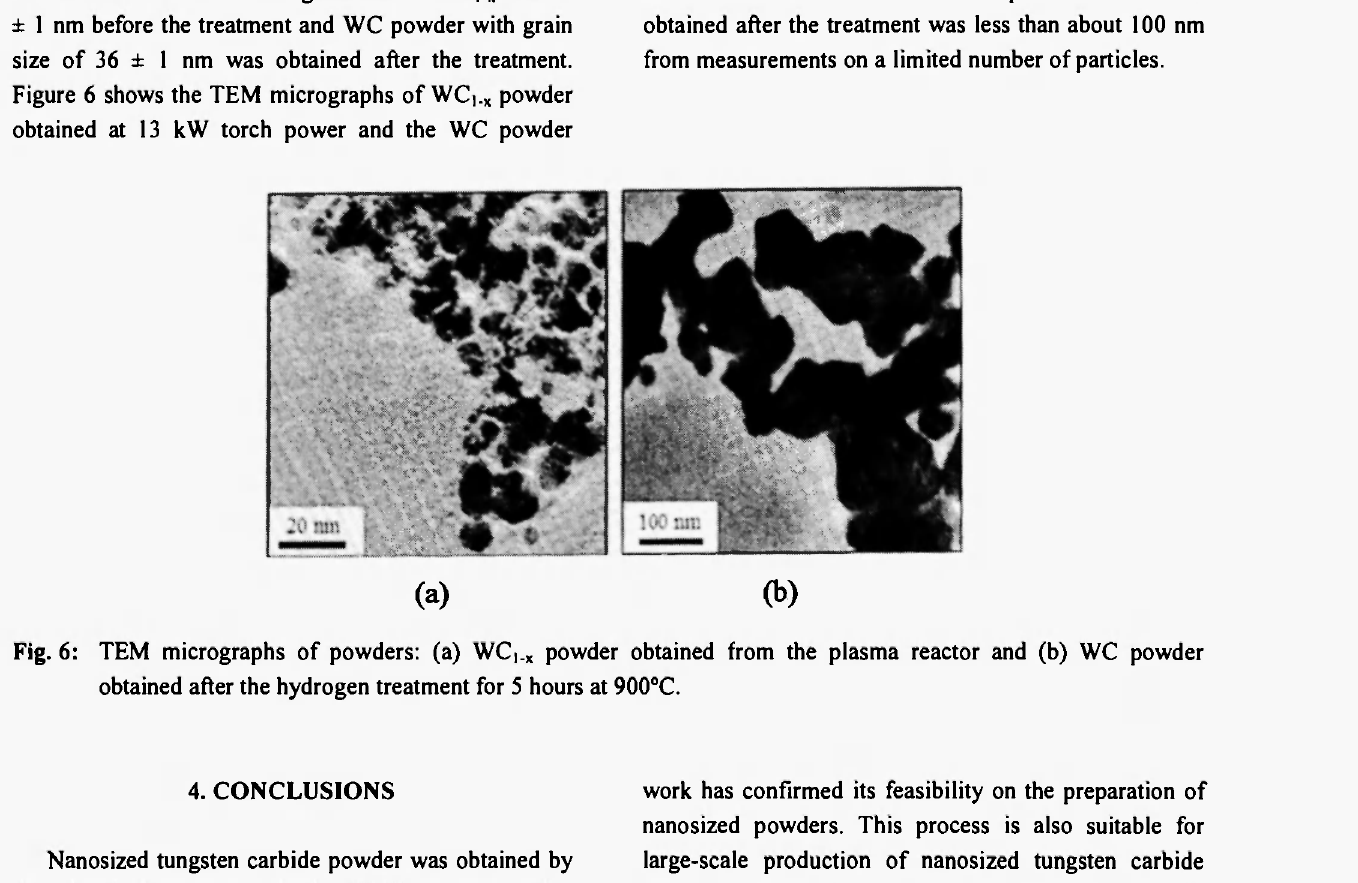
Fig. 6: TEM micrographs of powders: (a) WC,. X powder obtained from the plasma reactor and (b) WC powder obtained after the hydrogen treatment for 5 hours at